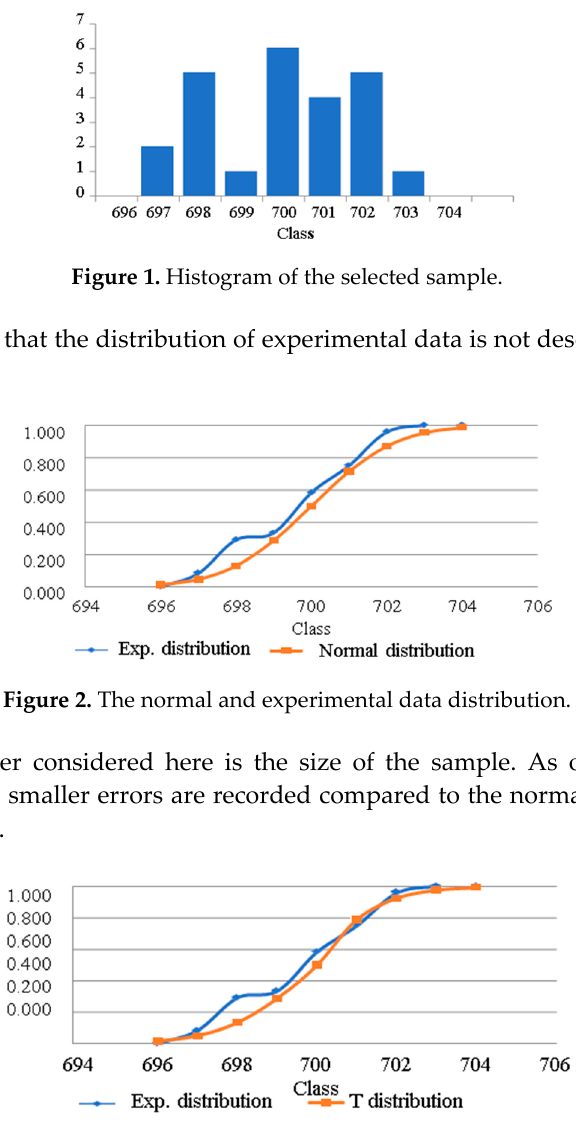
Figure 3. The normal and experimental data distribution for the sample with 23 elements.